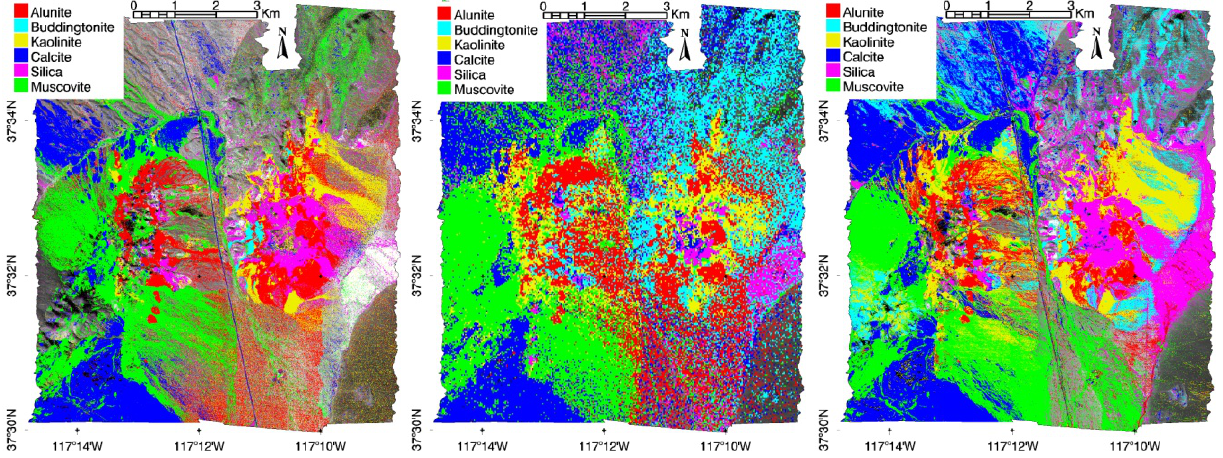
Figure 5. ( Left ) Mixture-Tuned-Matched-Filtering (MTMF) mineral map at 7.5 m resolution using 86 AVIRIS SWIR bands in the analysis; ( Center ) MTMF Mineral Map at 30 m resolution using ASTER’s 5 SWIR bands; ( Right ) MTMF Mineral Map at 7.5 m spatial using the 8 simulated WV-2 SWIR bands. Visual comparison indicates that the simulated WV-3 mineral map does a better job than ASTER of preserving the key mineral patterns shown in the AVIRIS